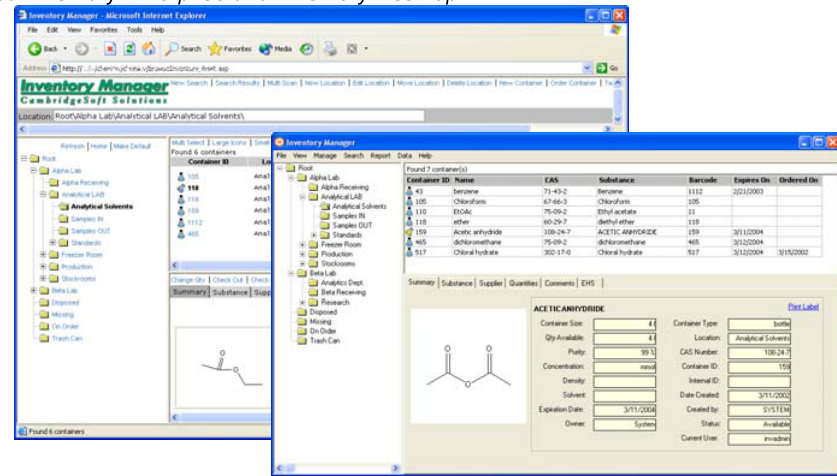
FIGURE 1: Web-based Inventory Enterprise and Inventory